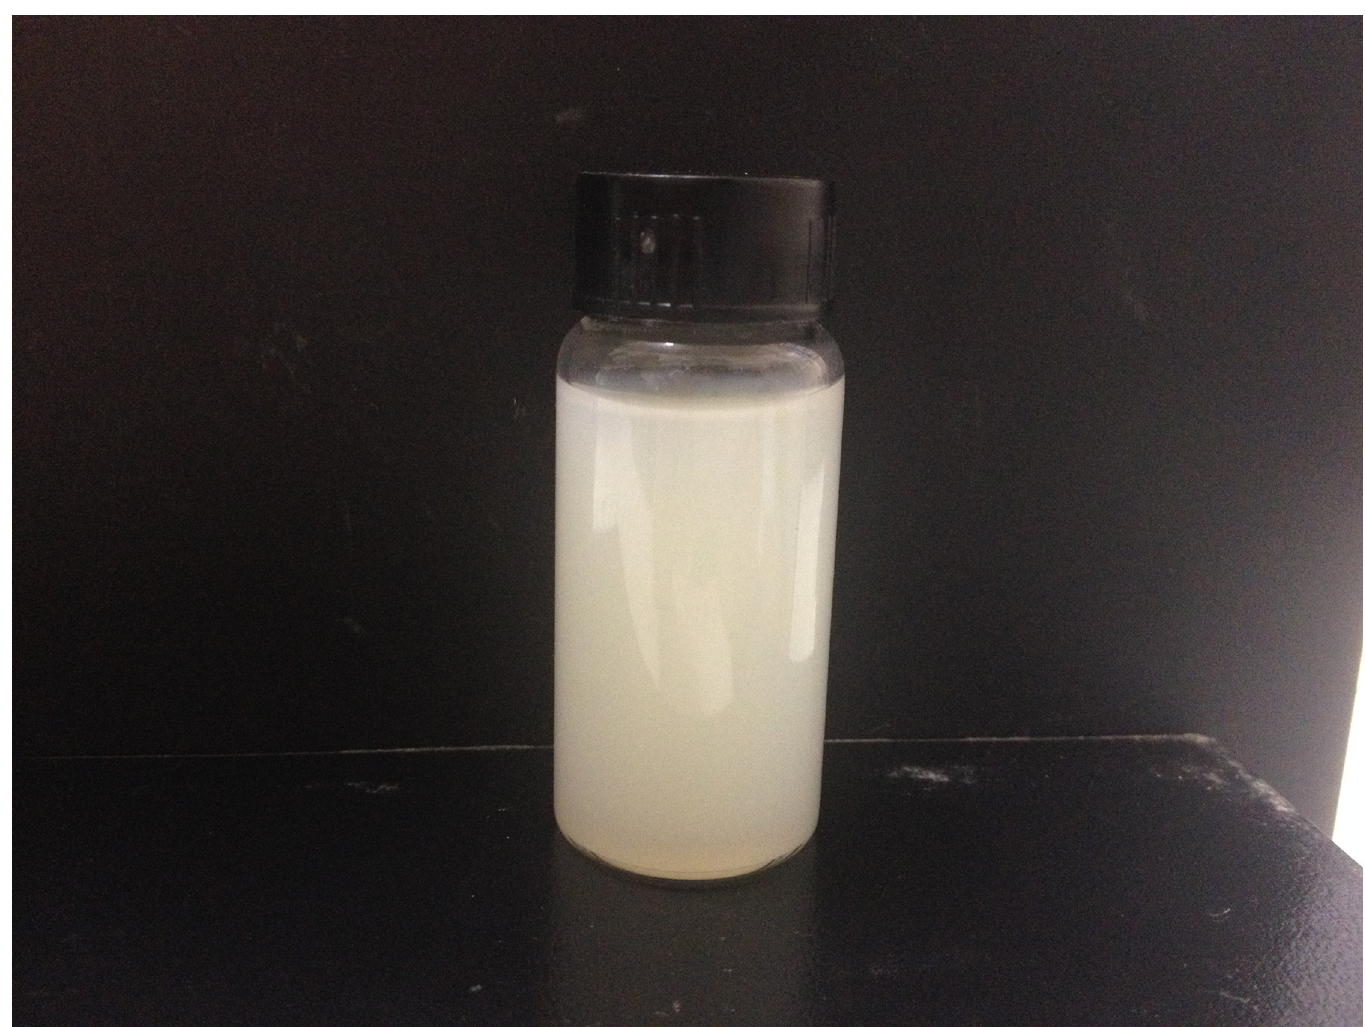
Fig 3. Optimized P . emarginatus nanoemulsion used for in vitro and in vivo biological assays.